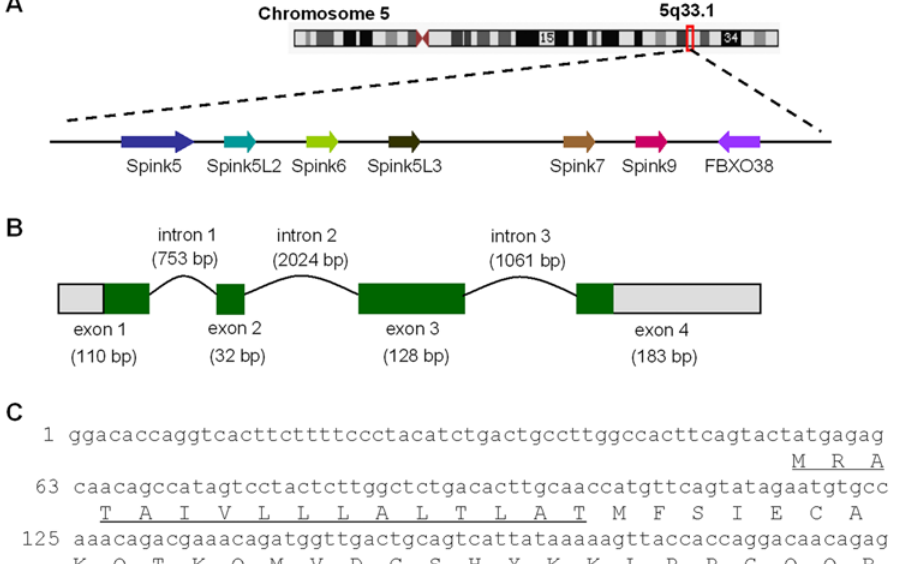
Figure 1. Identification of a new KLK5-inhibiting peptide in human stratum corneum. (A) RP-HPLC separation of extract stratum corneum extracts from human plantar callus. Top, components eluting between 0% and 100% acetonitrile. Bottom, KLK5-inhibiting-activity of the fractions. One out of three similar experiments is shown. Arrow indicates fractions with high activity to absorbance ratio at 20–21 min eluting time. (B) SDS page analyses of fractions eluting between 18 and 22 minutes. Since the fractions were not collected by time but by peaks, distance of fractions is not linear. A dominant peak of around 7 kDa is visible at 20–21 min eluting time. (C) ESI-MS analyses revealed a mass of 7058.18 kDa for the KLK5- inhibiting fraction. (D) Edman degradation resulted in the indicated N-terminal